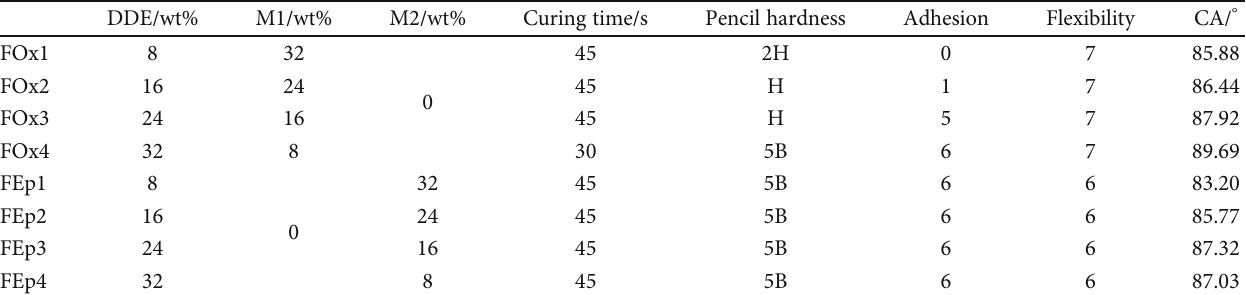
Table 4: Properties of 60wt% prepolymer C1 formulations with di ff erent monomer combinations.